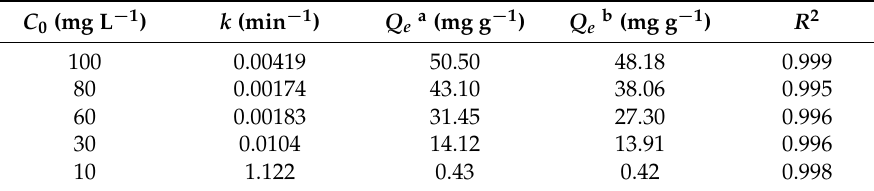
Table 4. Parameters from the kinetic modeling of lead on